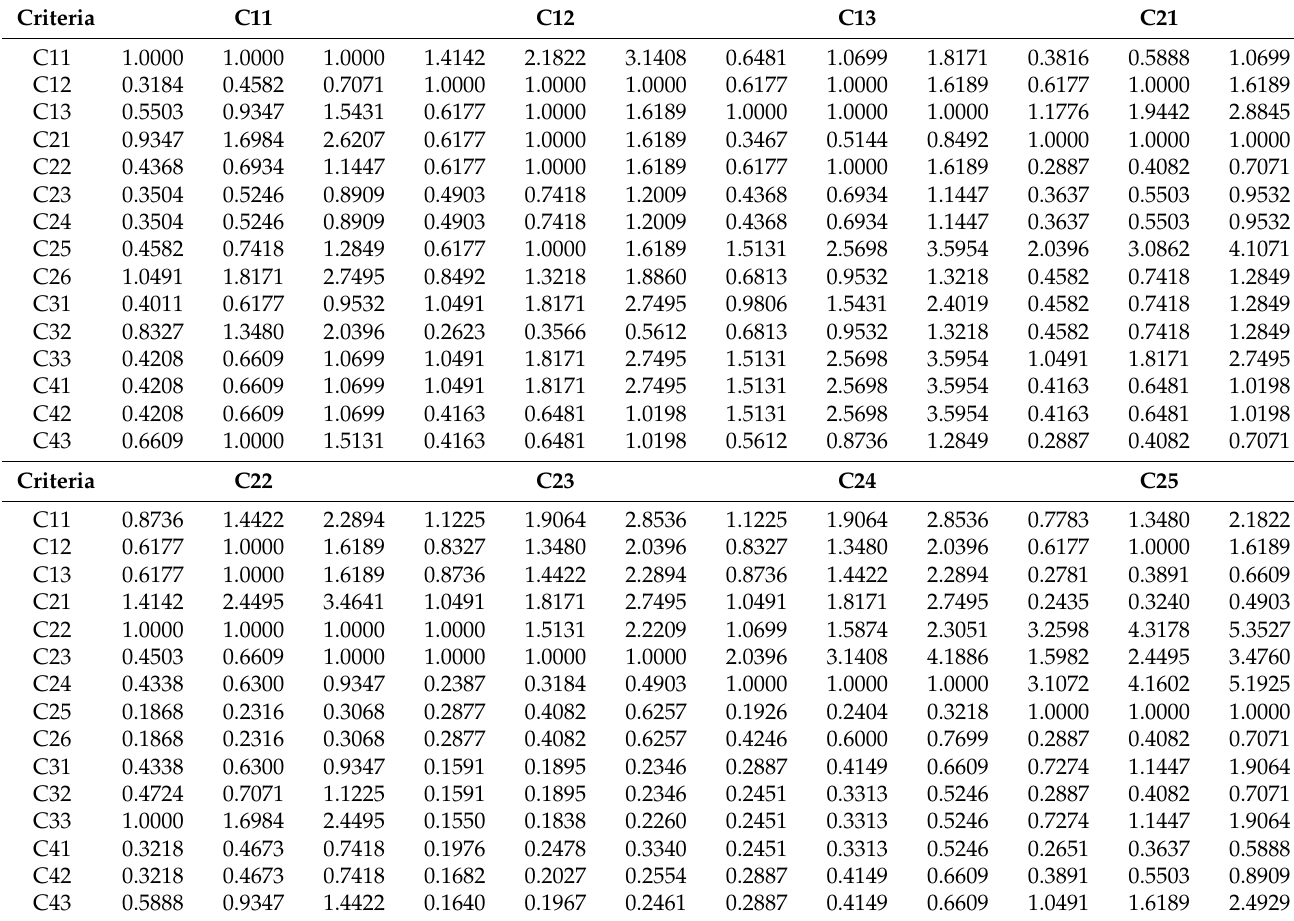
Table A1. The integrated fuzzy comparison matrix (FAHP